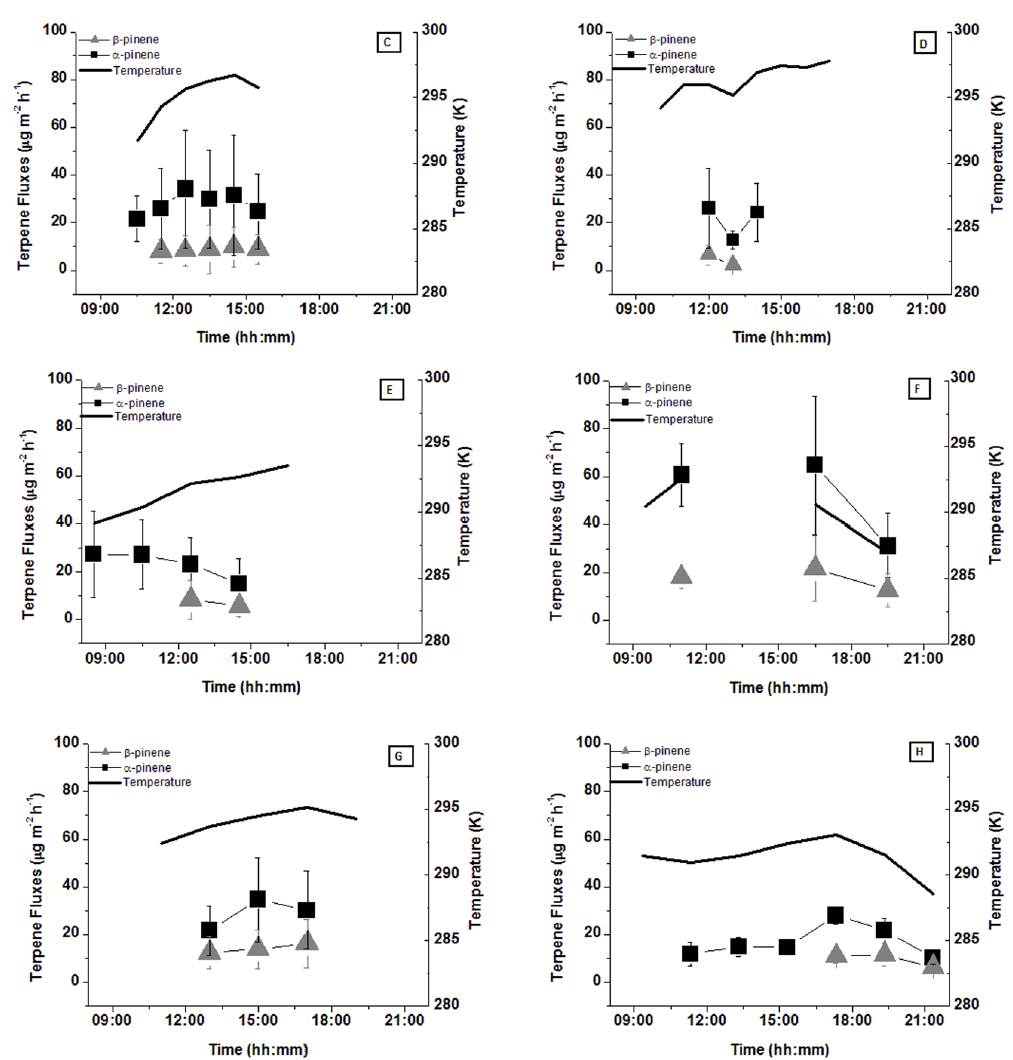
Fig. 8. α -pinene and β -pinene fluxes measured by DEA during six intensives during CABINEX 2009. Error bars represent the propagated uncertainty associated with each flux measurement data point. The secondary axis represents change in ambient temperature over the course of the